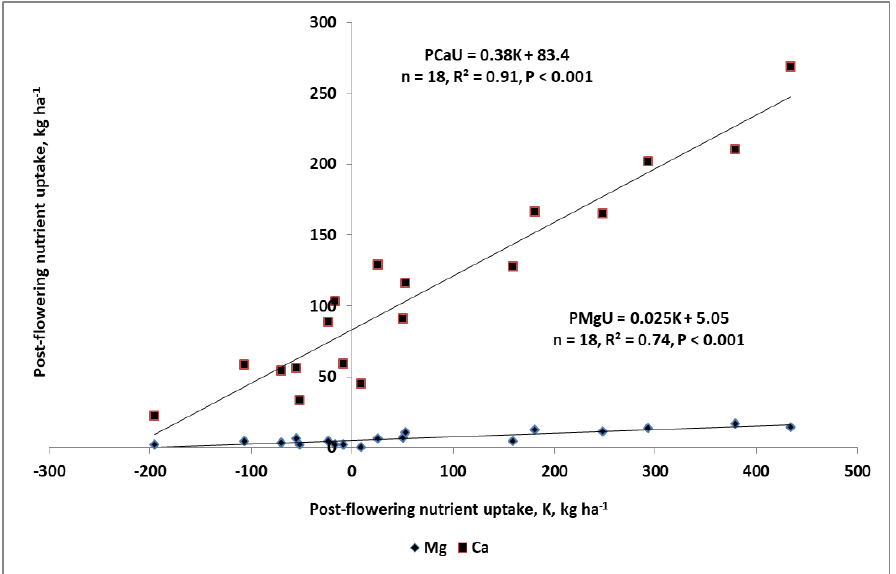
Figure 7. The impact of post-flowering K uptake on post-flowering uptake of calcium and magnesium.